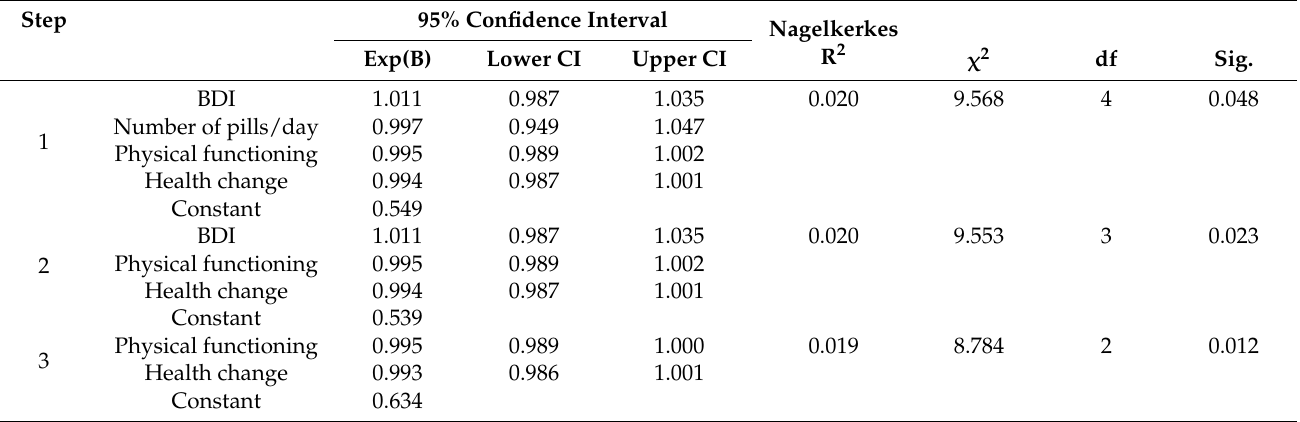
Table 2. Binominal logistic regression: medication change after discharge